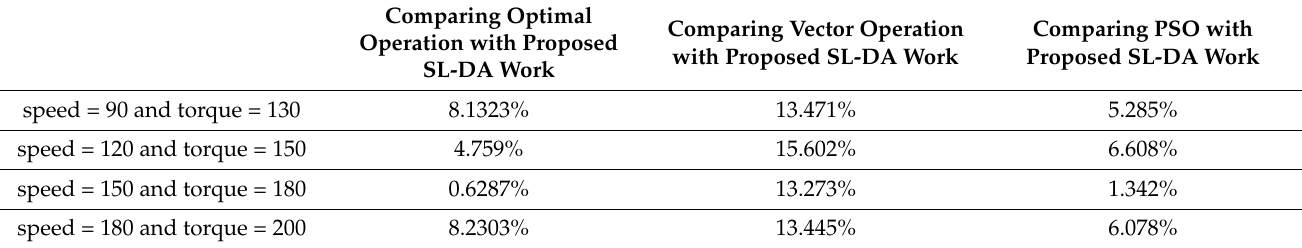
Table 3. Energy saving analysis of proposed work over state-of-the-art